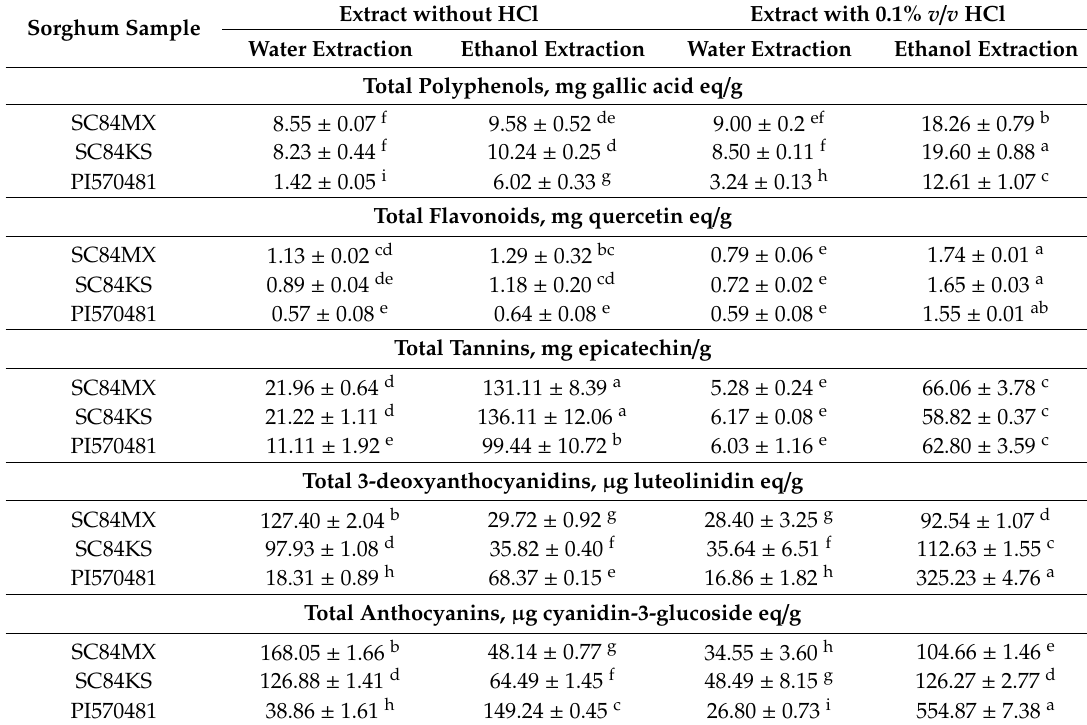
Table 1. Di ff erent contents of phenolic compounds as measured by spectroscopy in novel sorghum samples using di ff erent extraction